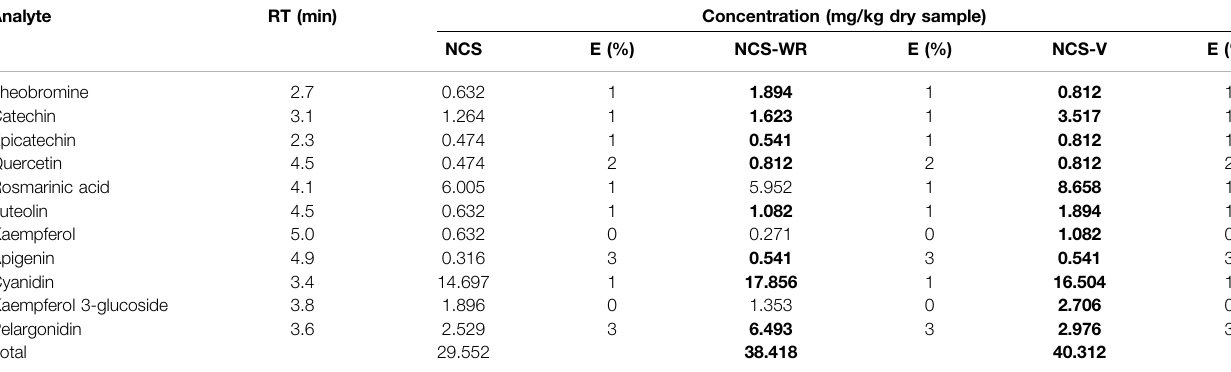
TABLE 1 | Identi fi ed polyphenolic compounds in each NCS extract through HPLC-MS. Analyte RT